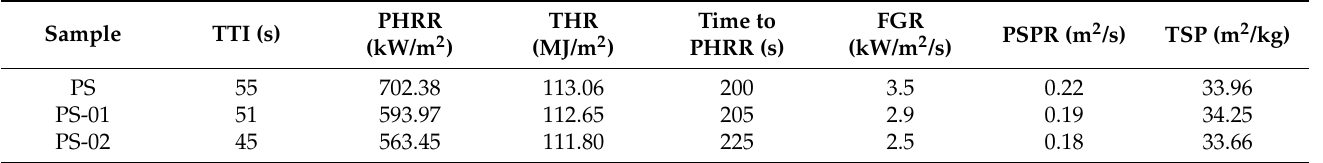
Table 3. Cone calorimeter test data for PS and its blends.